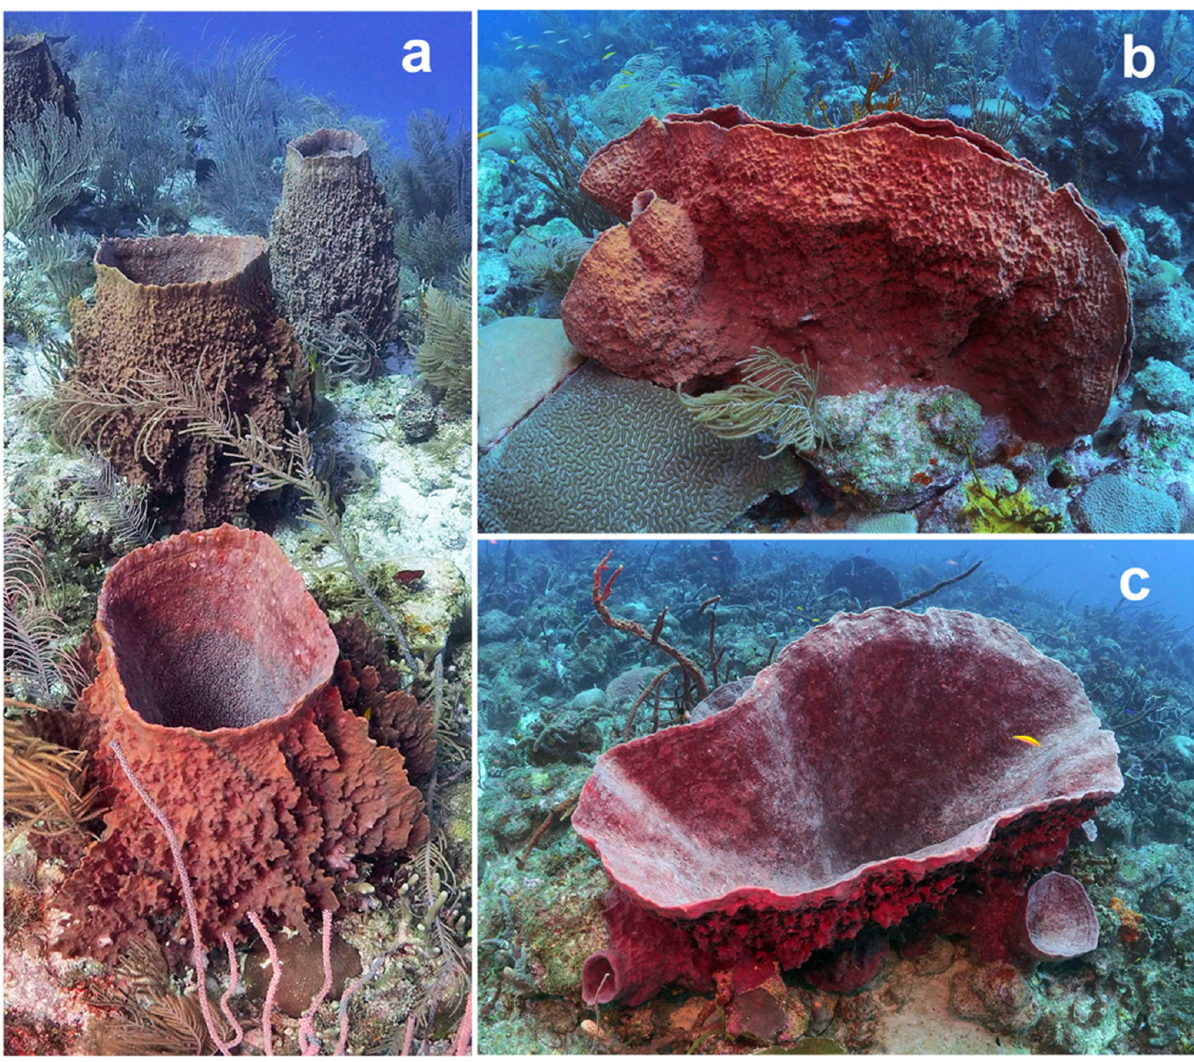
Figure 1. ( a ) Xestospongia muta , showing examples of the normal barrel morphotype off Carrie Bow Cay, Belize. ( b , c ) The clam and tub morphotypes, respectively, off the SW coast of Barbados. ( a ) Photograph taken at ~20 m depth on Carrie Bow Cay reef, March 2019. ( b , c ) Photographs taken at ~20 m depth on Pine Shallows reef, near Needhams Point, January 2019. Sponges are ~0.5 m, ~1.5 m and ~2 m across, respectively.